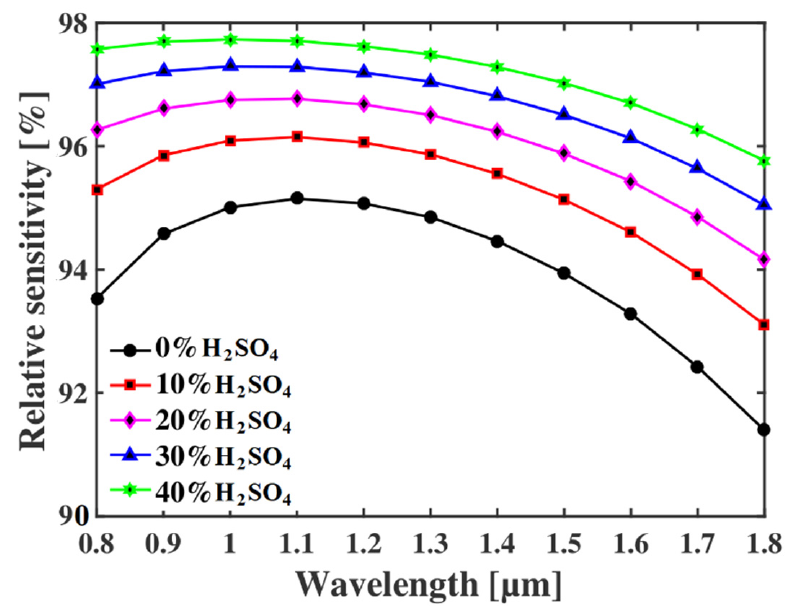
Figure 4. Relative sensitivity of the proposed detector for different wavelengths at p = 3 µm.